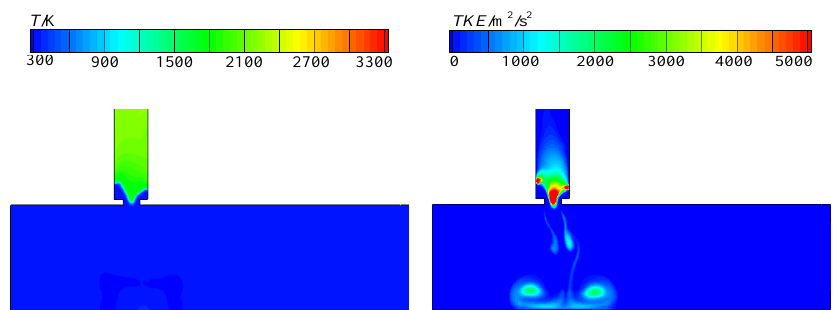
Figure 6. Temperature field and turbulent kinetic energy field at 1.575 ms.